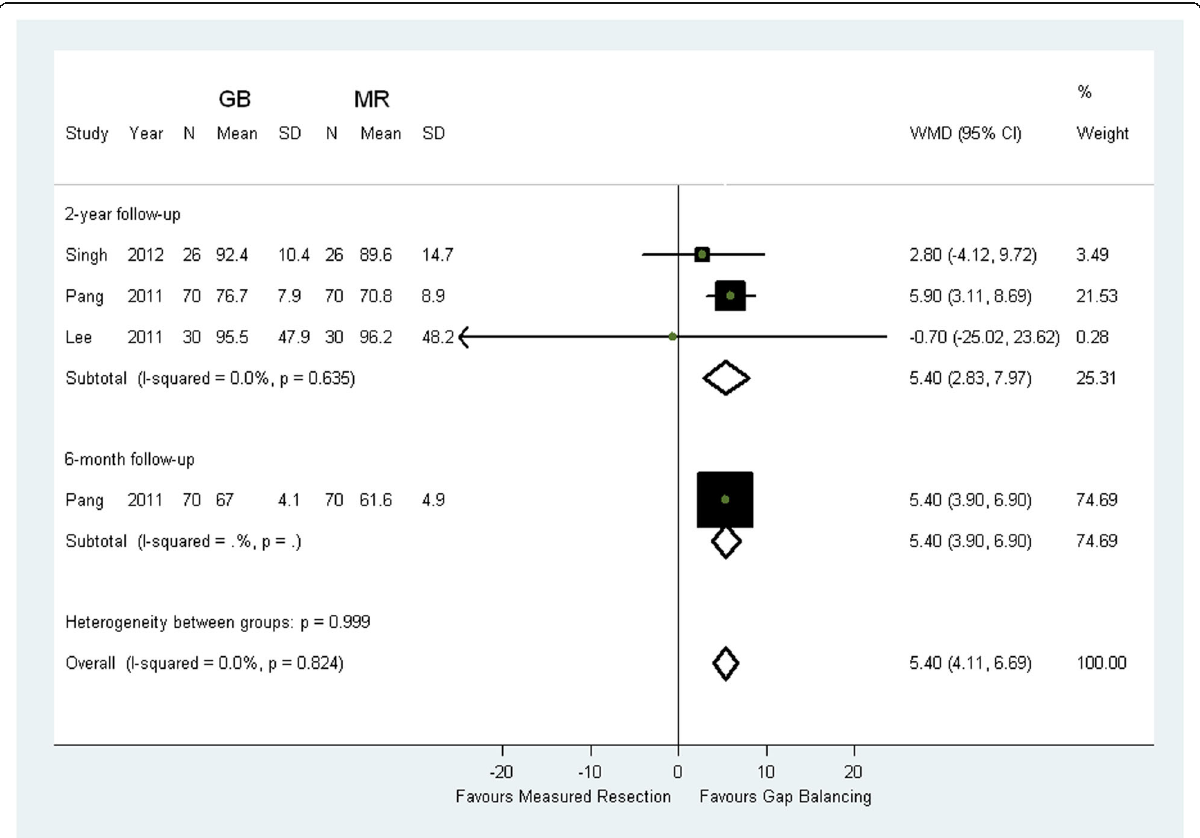
Fig. 3 Comparison of KSS scores for function between measured resection (MR) group and gap balancing (GB) group. SD = standard deviation, CI = confidence